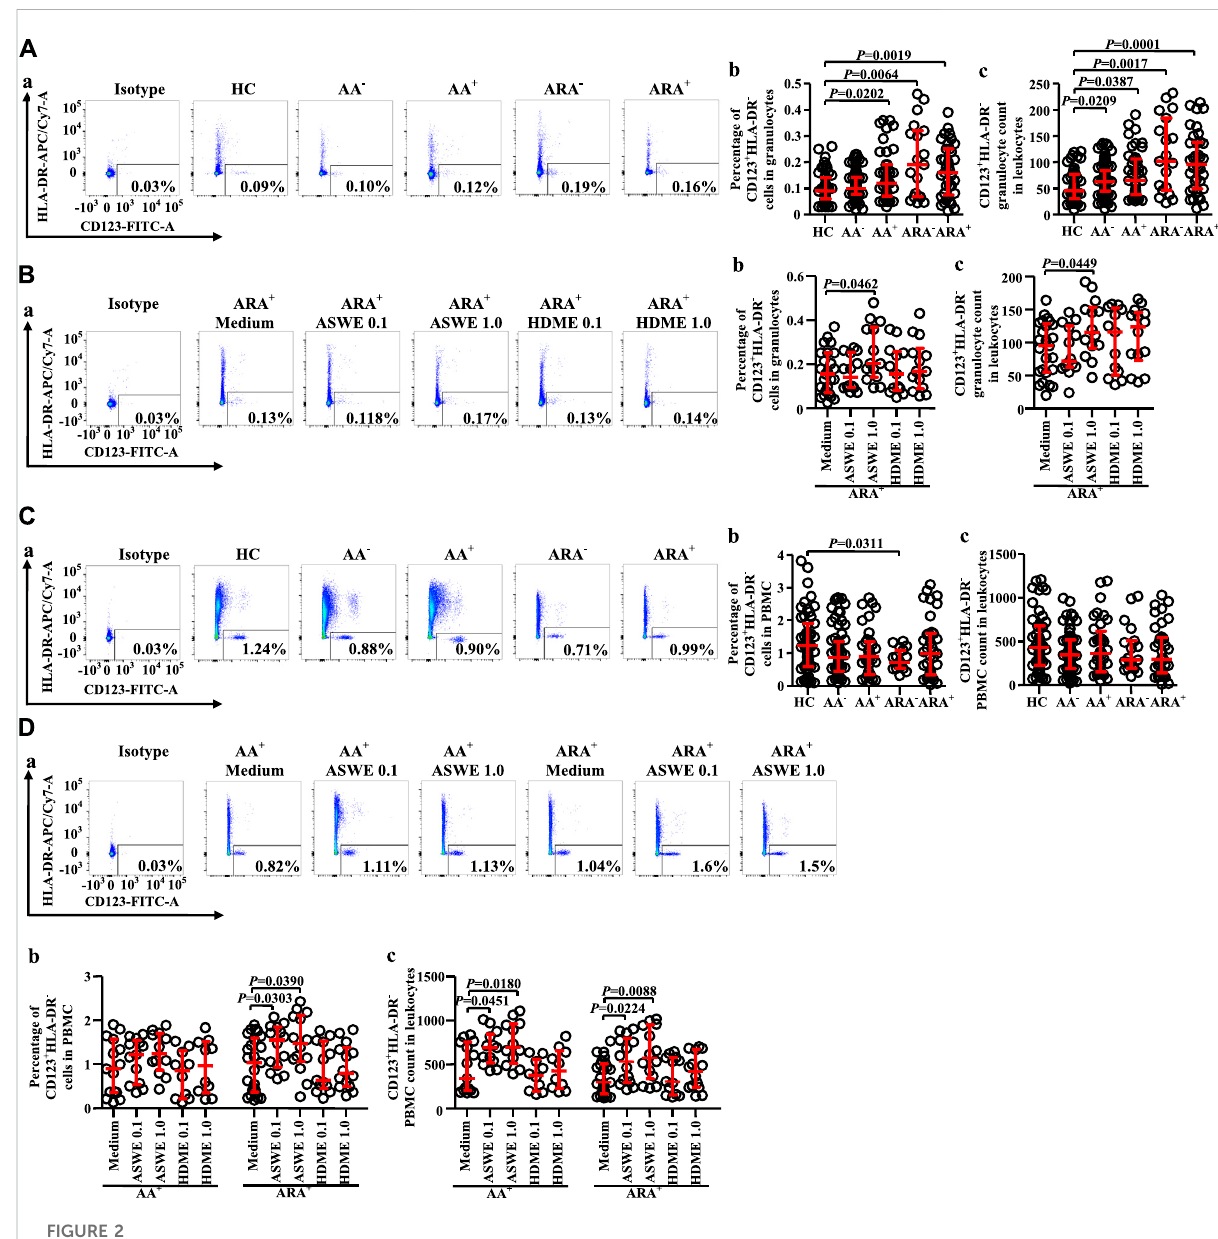
FIGURE 2 Flow cytometry analysis of proportions and numbers of CD123+HLA-DR − cells in granulocytes and PBMC of allergic asthma (AA) and healthy control (HC) subjects. (A) and (C) Proportions and numbers of CD123+HLA-DR − cells in granulocytes and PBMC. (B) and (D) proportions and numbers of CD123+HLA-DR − cells in granulocytes and PBMC after house dust mite extract (HDME, μ g/ml) and Artemisia sieversiana wild allergen extract (ASWE, μ g/ml) challenge. (a) representative graphs of the gating strategies. (b) Percentages indicated cells of skin prick test (SPT)- negative AA (AA − ), SPT-positive AA (AA+), SPT-negative AA combined with allergic rhinitis (ARA − ), SPT-positive AA combined with allergic rhinitis (ARA+) patients, and HC subjects. (c) numbers of CD123+HLA-DR − cells in